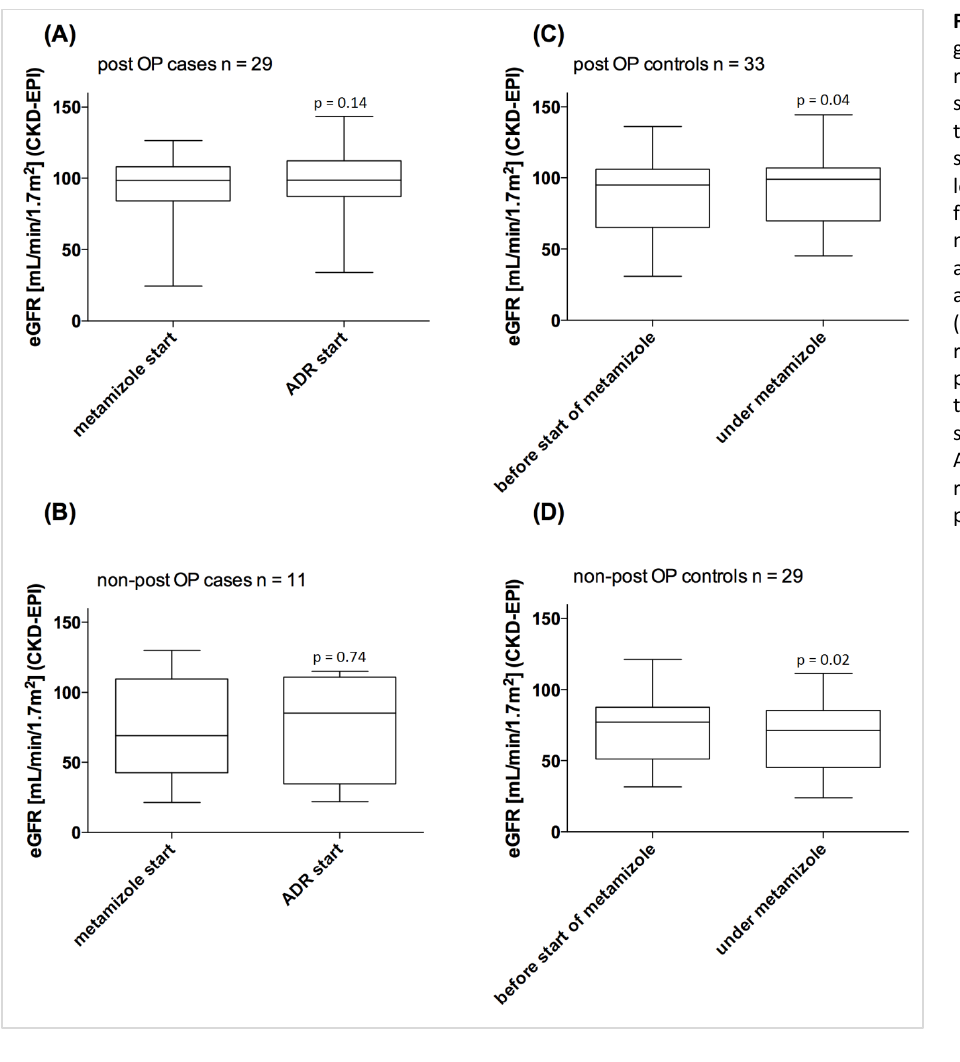
Figure 3: Estimated glomerular filtration rate (eGFR) at the start of metamizole therapy and at ADR start (case groups, left side), eGFR be- fore the start of metamizole therapy and under met- amizole therapy (control groups, right side), com- pared with use of the Wilcoxon signed-rank